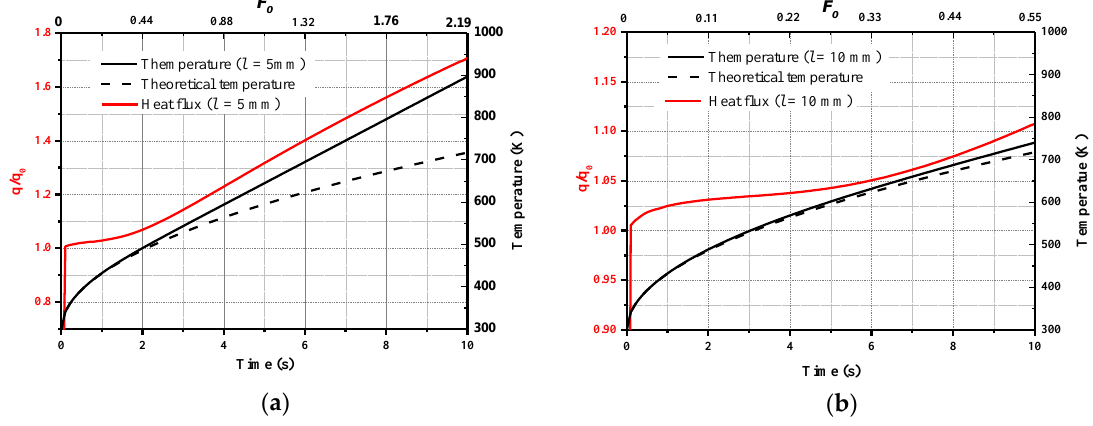
Figure 6. The surface temperature and heat flux: ( a ) l = 5 mm; ( b ) l = 10 mm.